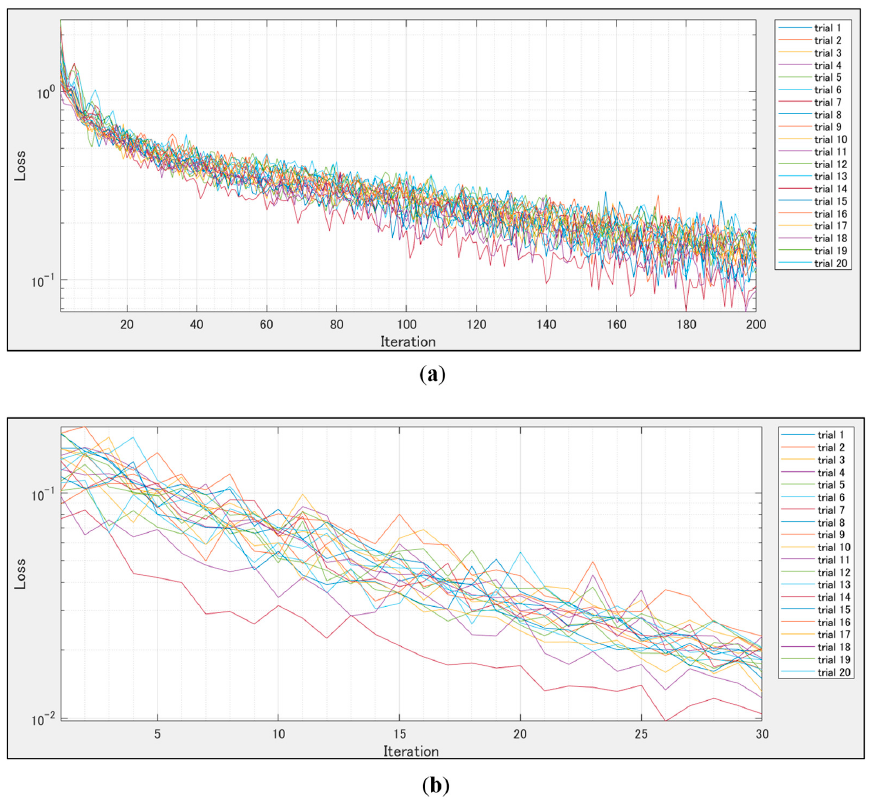
Figure 11. Loss transition for all trials. Y -axis is loss, and x -axis represents epoch. ( a ) Loss transition in First Half ; ( b ) Last Half .